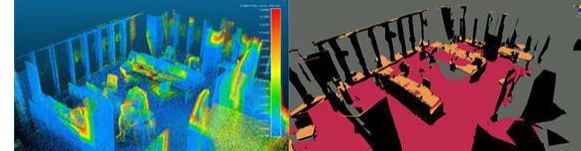
Figure 7: Scanned environment. MLS point cloud (left), indicating distance to the PoC scan